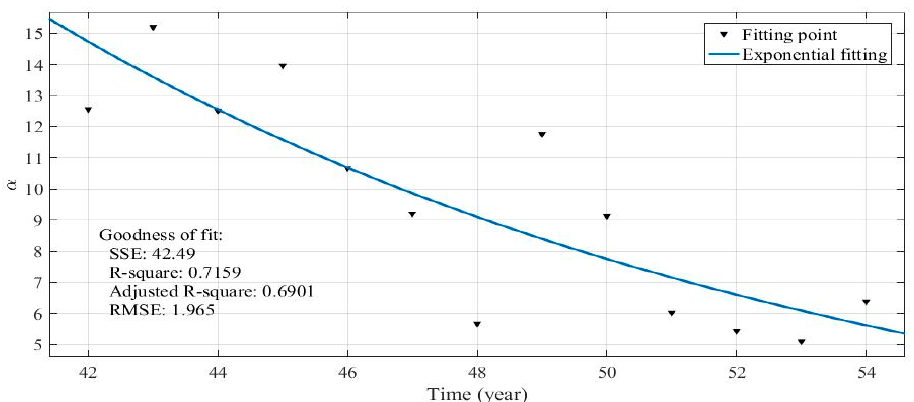
Figure 12. Shape parameter ( α )